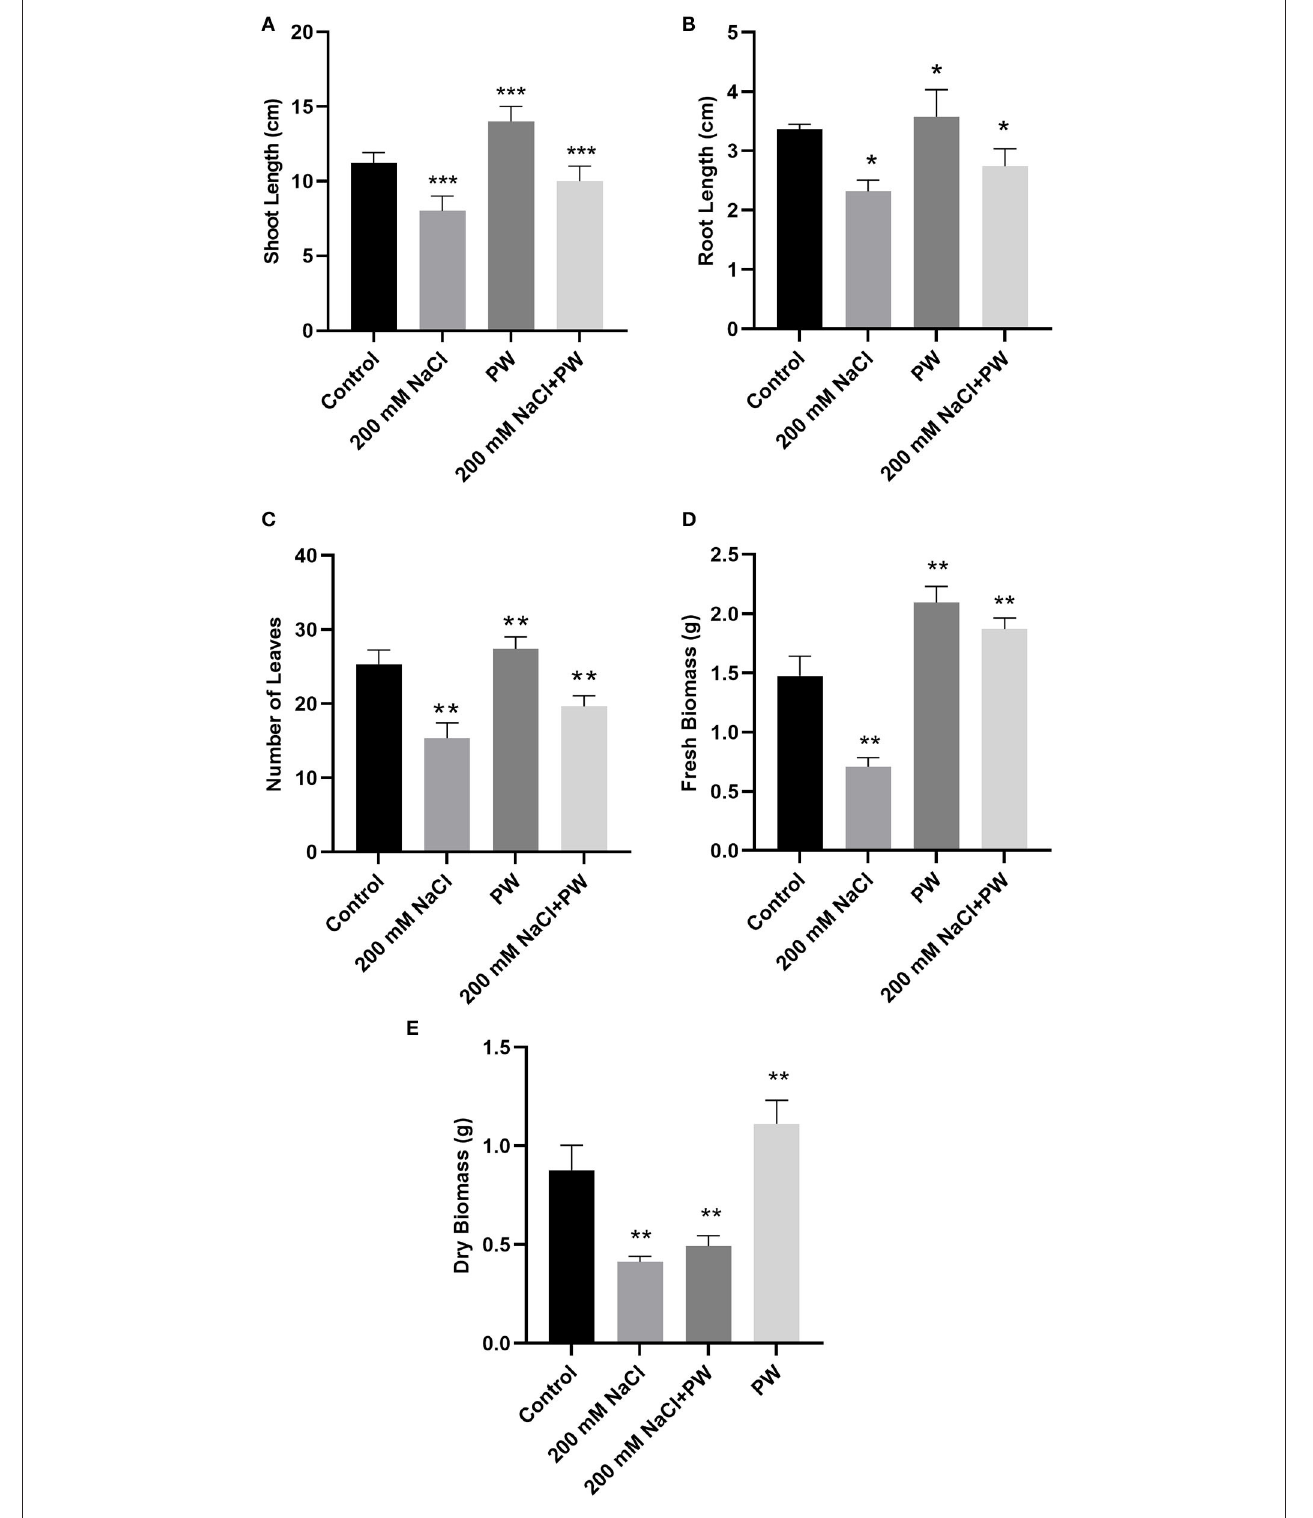
FIGURE 2 | Treatment of maize with S. lycopersici (PW) under normal and salt-stressed conditions. (A) Shoot length, (B) root length, (C) number of leaves, (D) fresh biomass, and (E) dry biomass. Bars indicate mean ± standard error from three replicates at a significant level of p ≤ 0.05. Significant differences were represented by asterisks (*, **, ***) at p ≤ 0.05.